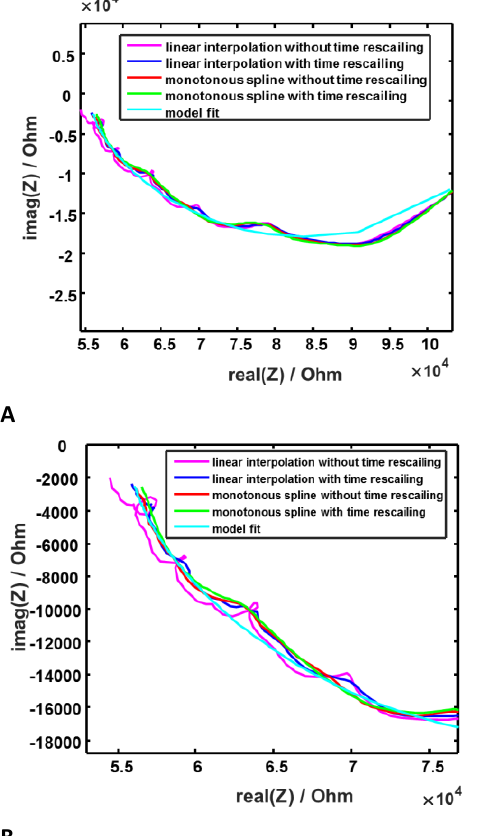
Fig. 7: Model parameters after fitting the measured electrical signals for spheroid in the chamber. A : simple fit of the distribution of relaxation times model and B : the same model fit with proposed